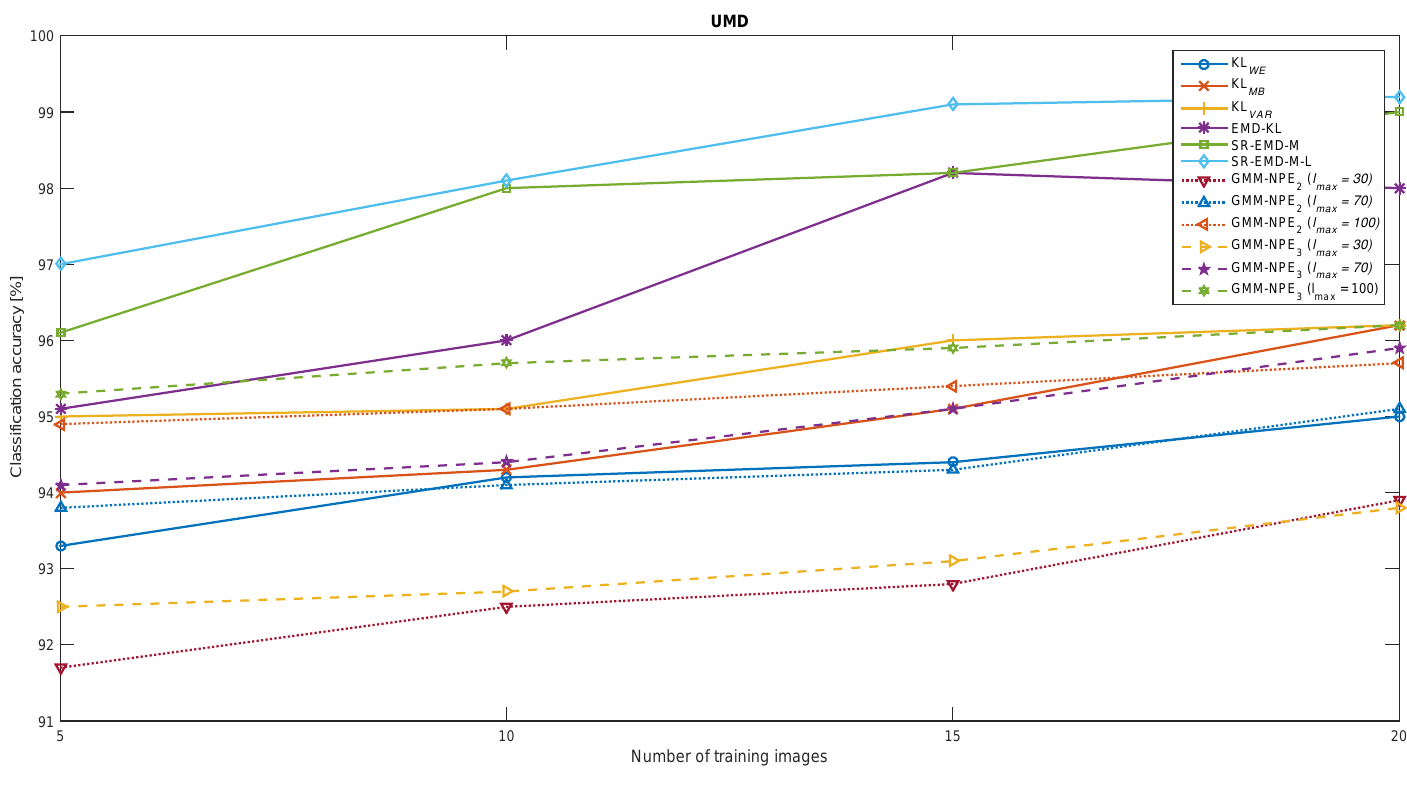
Figure 1. Classification rate vs. the number of training examples for the UMD texture database for the proposed method in comparison to baseline